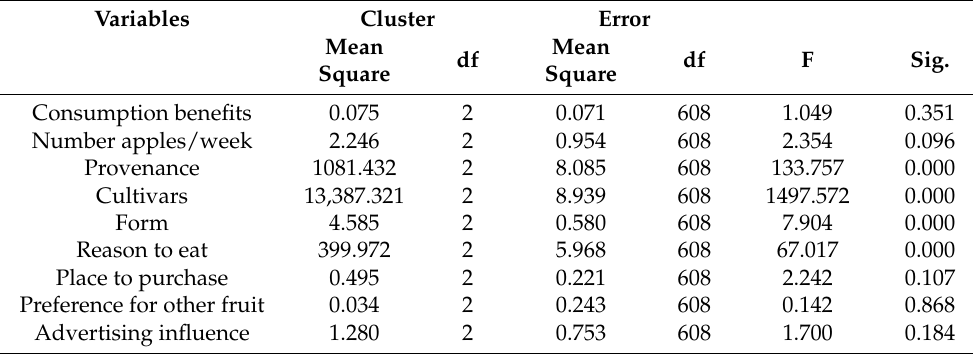
Table 7. ANOVA results from the nine